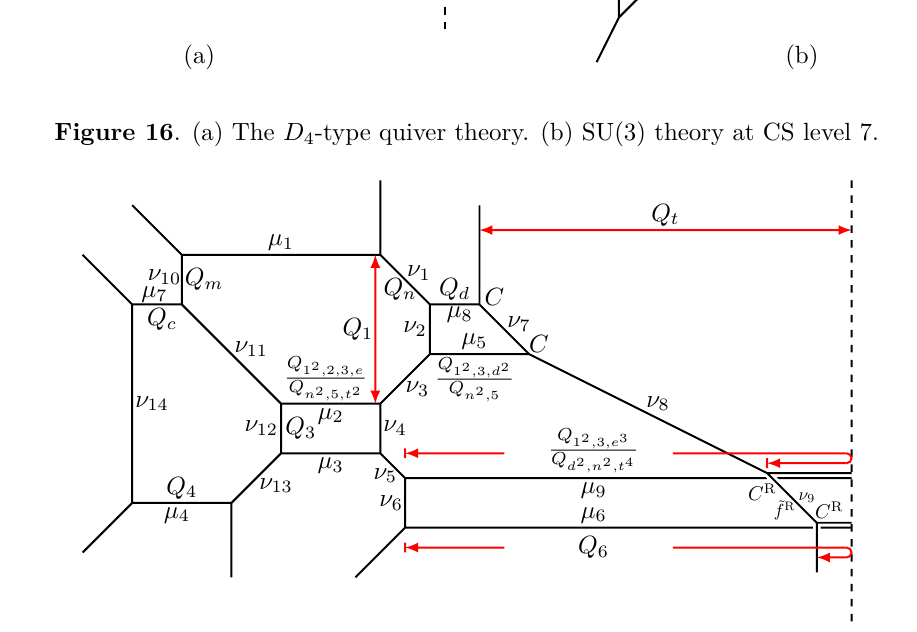
Figure 17 . The D 4 -type quiver theory with separated SU(2) sub webs on the